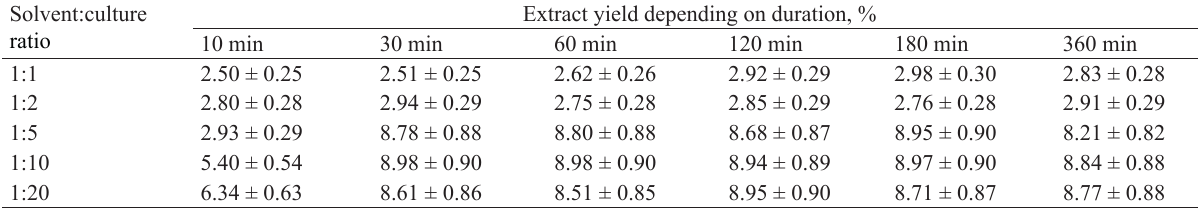
Table 3 Dry extract yield of biologically active substances from dried ginseng suspension culture biomass depending on extraction time (at 45°C) Solvent:culture